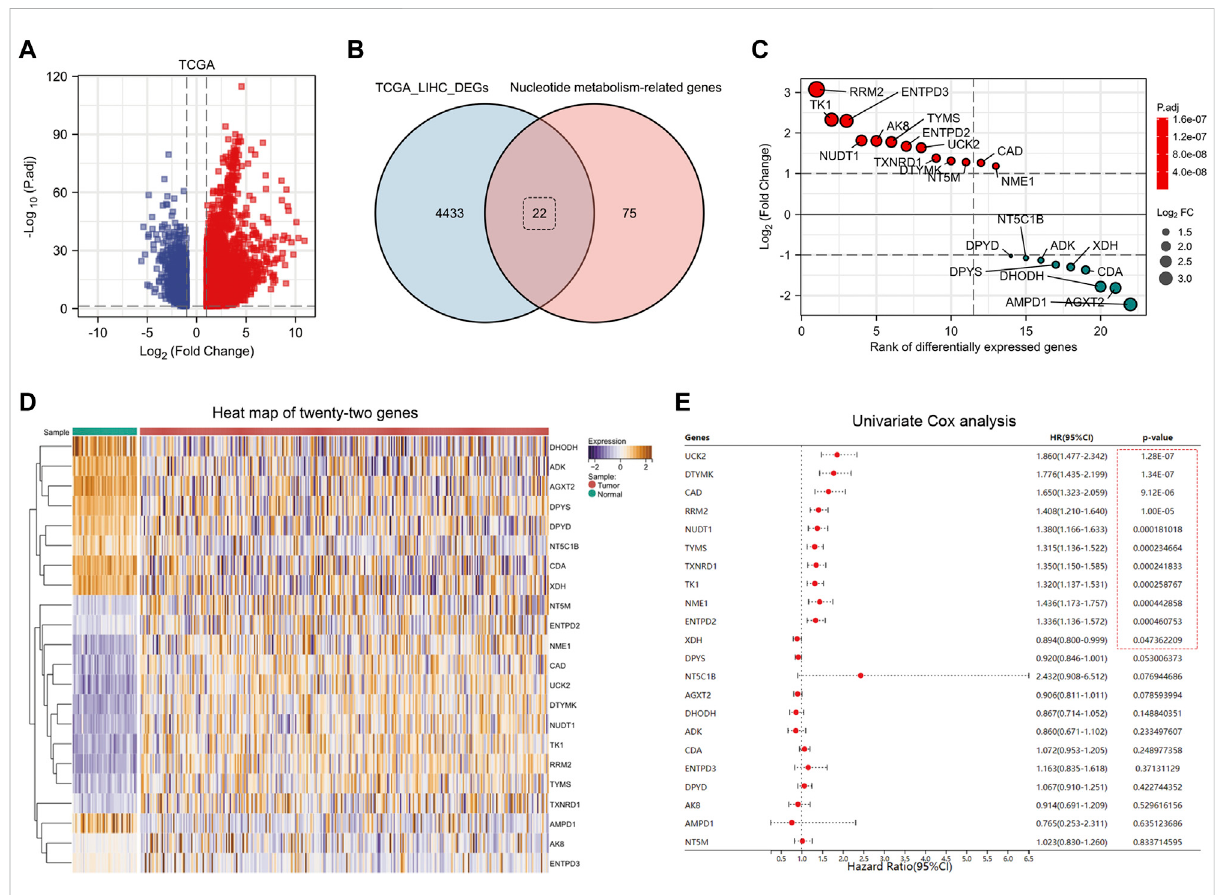
FIGURE 1 Identi fi cationofelevennucleotidemetabolismgenesassociated withprognosis inhepatocellularcarcinoma. (A) DEGs inTCGA-LIHCdatabase were identi fi ed using DESeq2 algorithm (FDR < 0.05, Log2|FC| > 1). (B) Twenty-two DEGs related to nucleotide metabolism were screened by Venn diagram. (C) Fold changes of the twenty-two DEGs. (D) Heat map showed the expression differences of twenty-two genes in paracancerous versus tumor tissues (after normalization). (E) Univariate Cox analysis screened eleven prognosis-related nucleotide metabolism